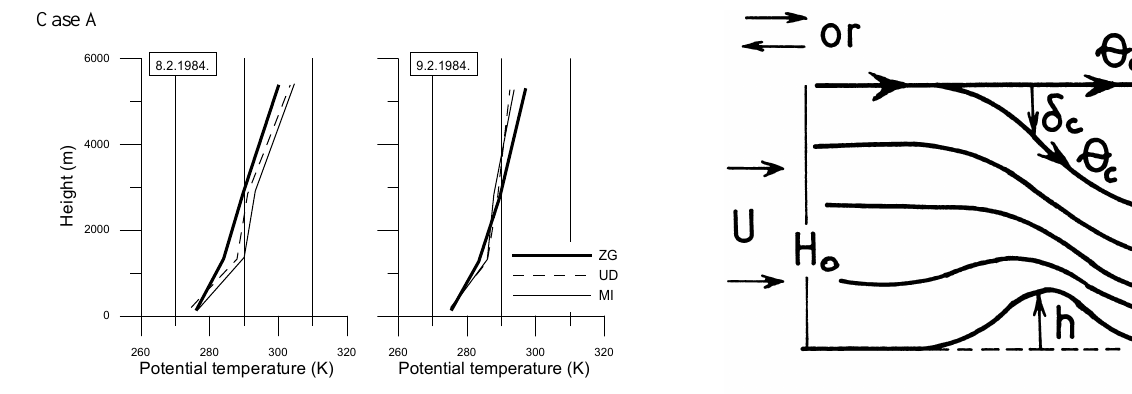
Fig. 10. Schematics of Smith’s (1985) hydraulic model for severe downslope winds.